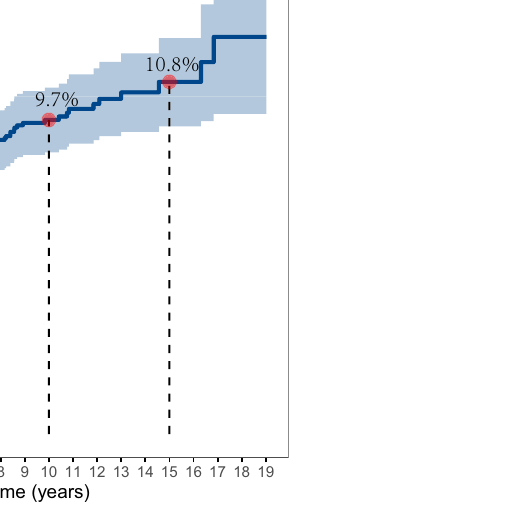
Figure 1. The overall cumulative recurrence